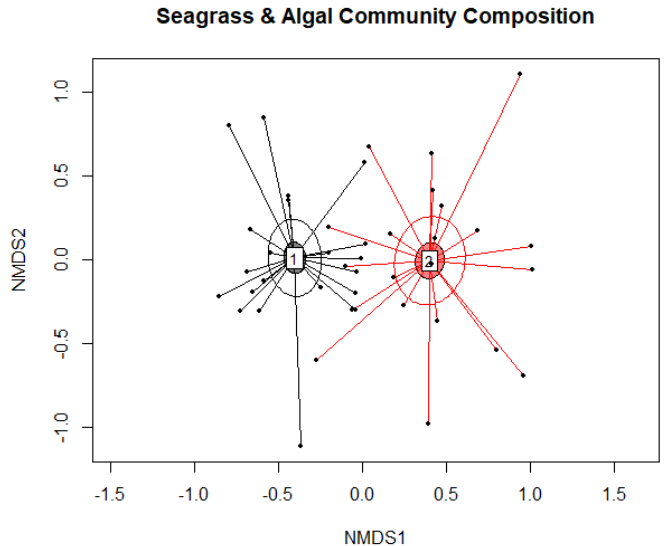
Figure A1. Ordination plots of seagrass and macroalgal community between sites at Green Island. Ordination showed significant community differences between Site 1 and 2 ( p < 0.001, R 2 = 0.5805, stress = 0.20). Individual samples are denoted by black dots, which are connected to their respective centroids. Lower and upper 95% confidence intervals (shaded area) for each centroid are also shown.